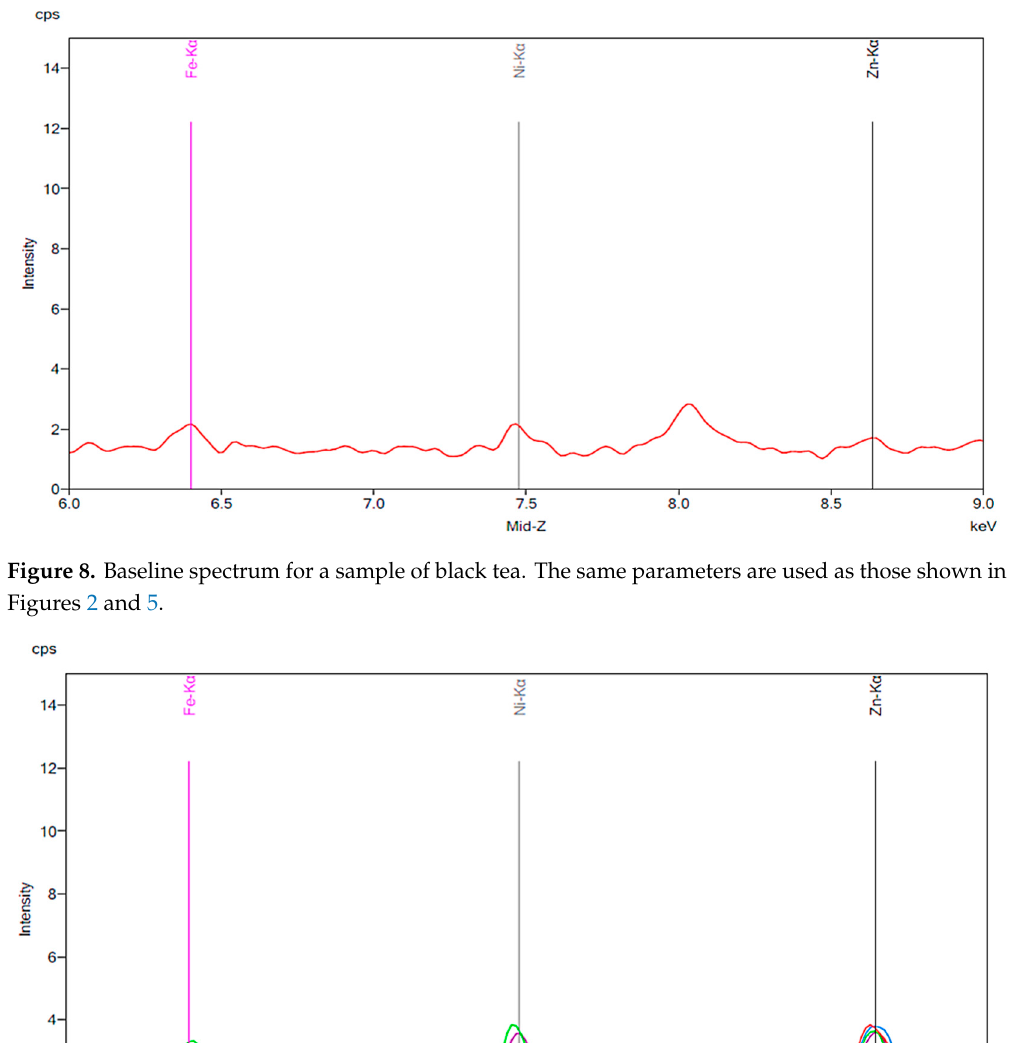
Figure 7. The same results as Figure 6 are indicated by the red and green peaks. For this experiment, the blue peaks represent a new artificial tooth after wear. The purple peaks correspond to the same artificial tooth following 24 h exposure to cola fluid.